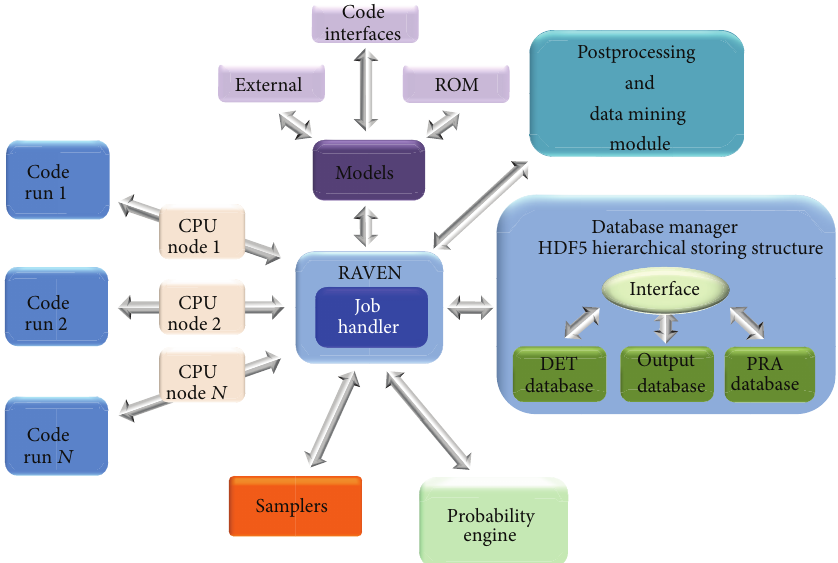
Figure 4: Scheme of RAVEN statistical framework components.